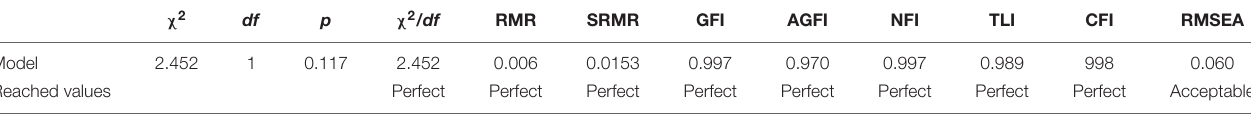
TABLE 6 | Fit indexes for proposed